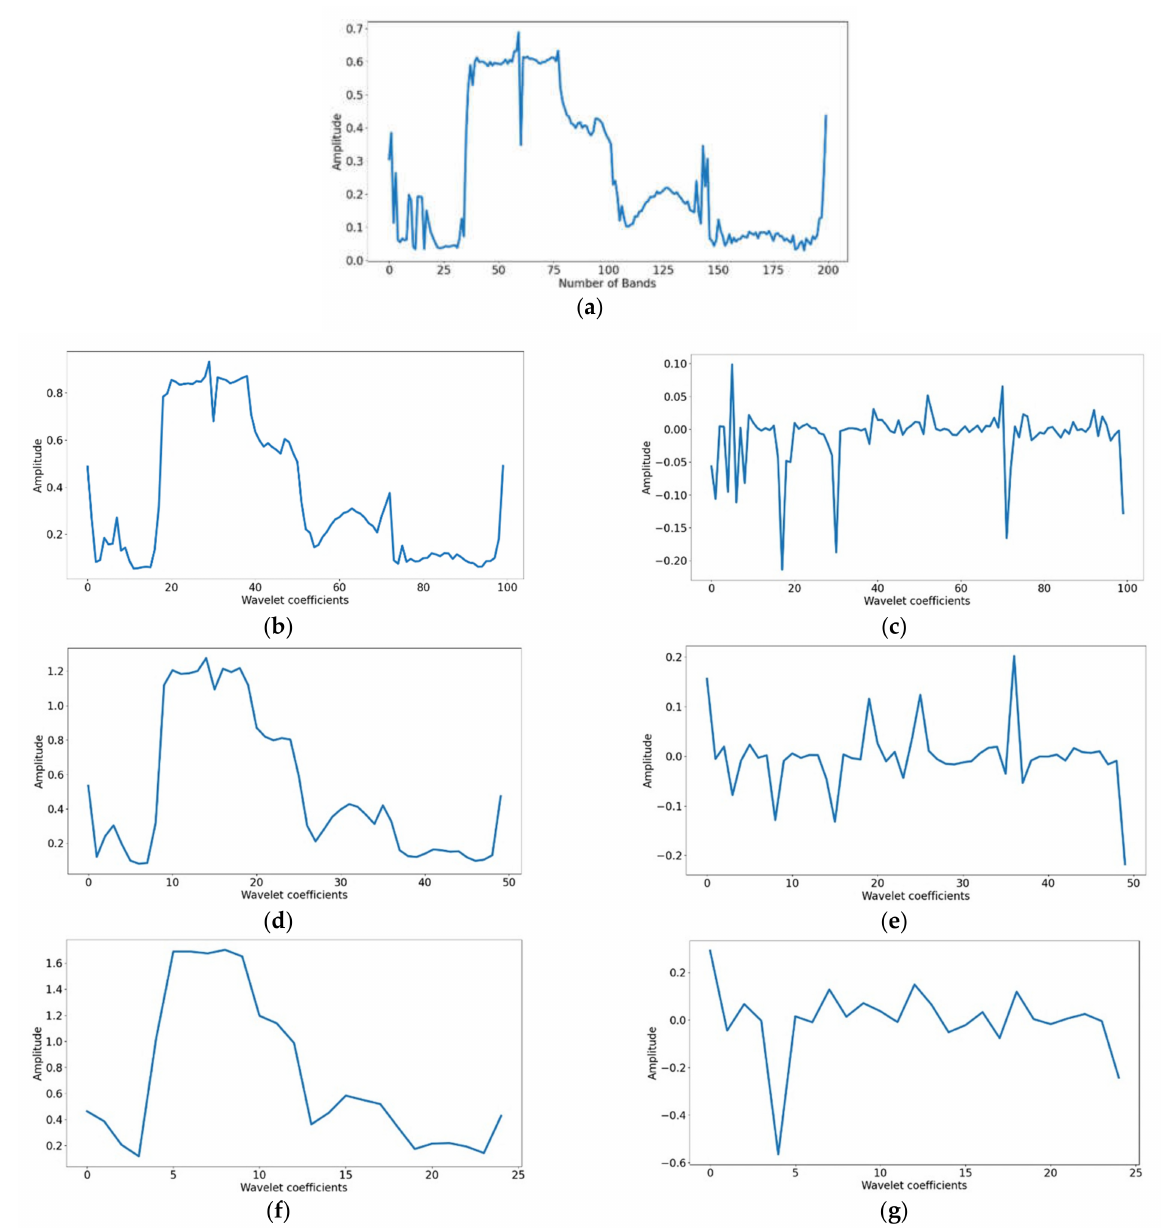
Figure 5. An example of wavelet coefficients based on the Haar wavelet for a hyperspectral pixel in the Indian Pines, [36], dataset: ( a ) hyperspectral signature, ( b ) the low (L) coefficients for the first level decomposition (N = 1), ( c ) the high (H) coefficients for the first level of decomposition (N = 1), ( d ) the low (LL) coefficients for the second level of decomposition (N = 2), ( e ) the high (LH) coefficients for the second level of decomposition (N = 2), ( f ) the low (LLL) coefficients for the third level of decomposition (N = 3), ( g ) the high (LLH) coefficients for the third level of decomposition (N =